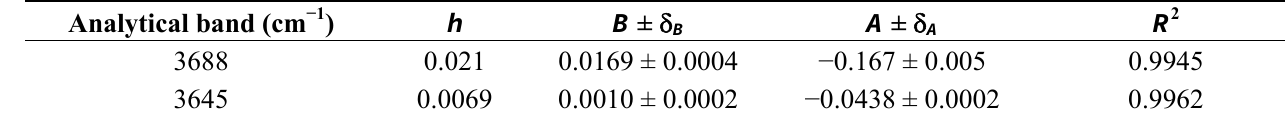
Table 5. LCM curve